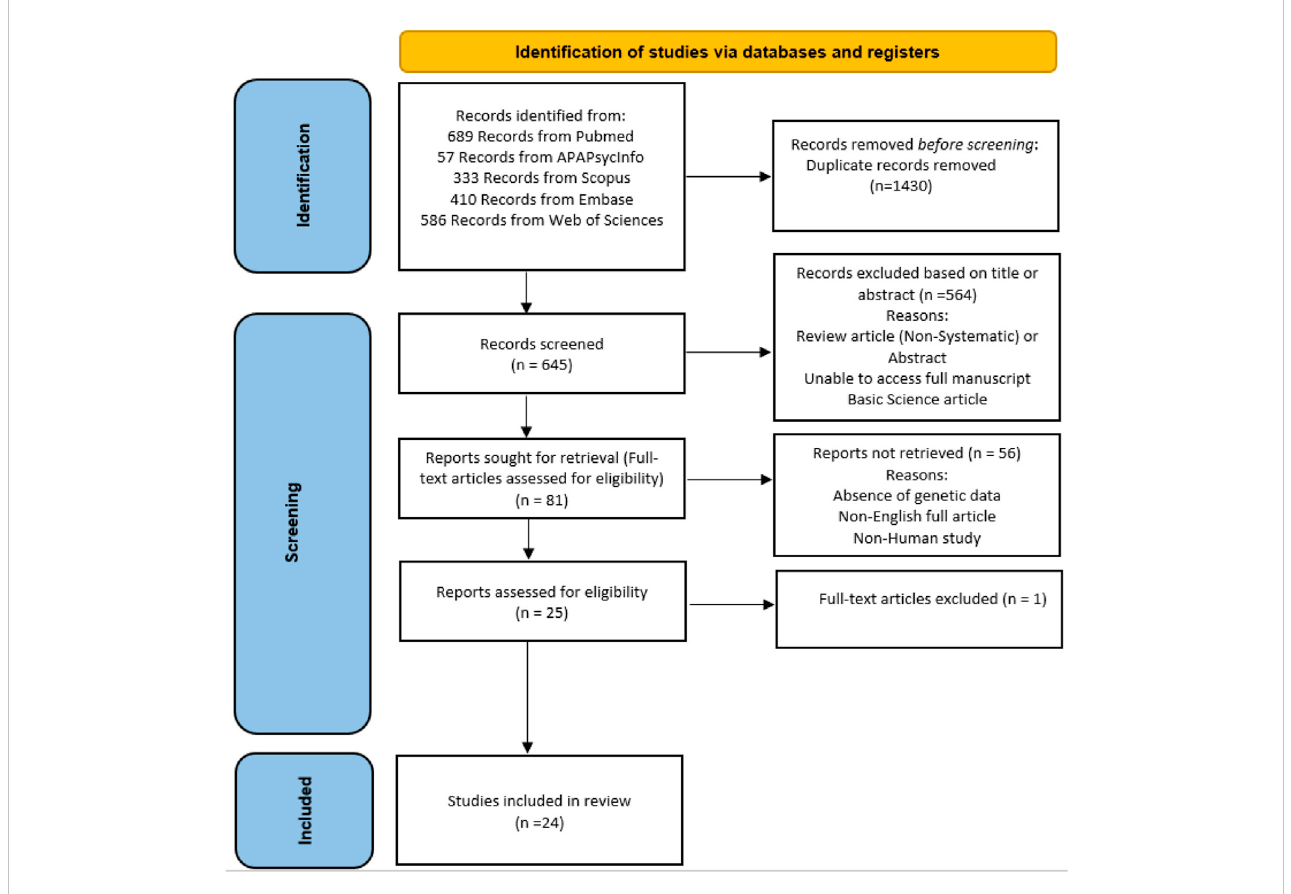
FIGURE 1 PRISMA fl ow diagram of study identi fi